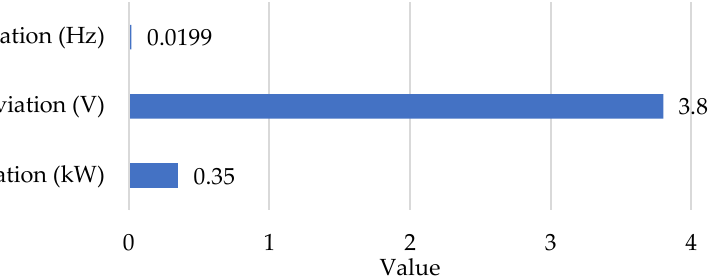
Figure 10. Maximum dynamic frequency deviation, maximum dynamic voltage deviation and maximum dynamic power optimization deviation of DG1.